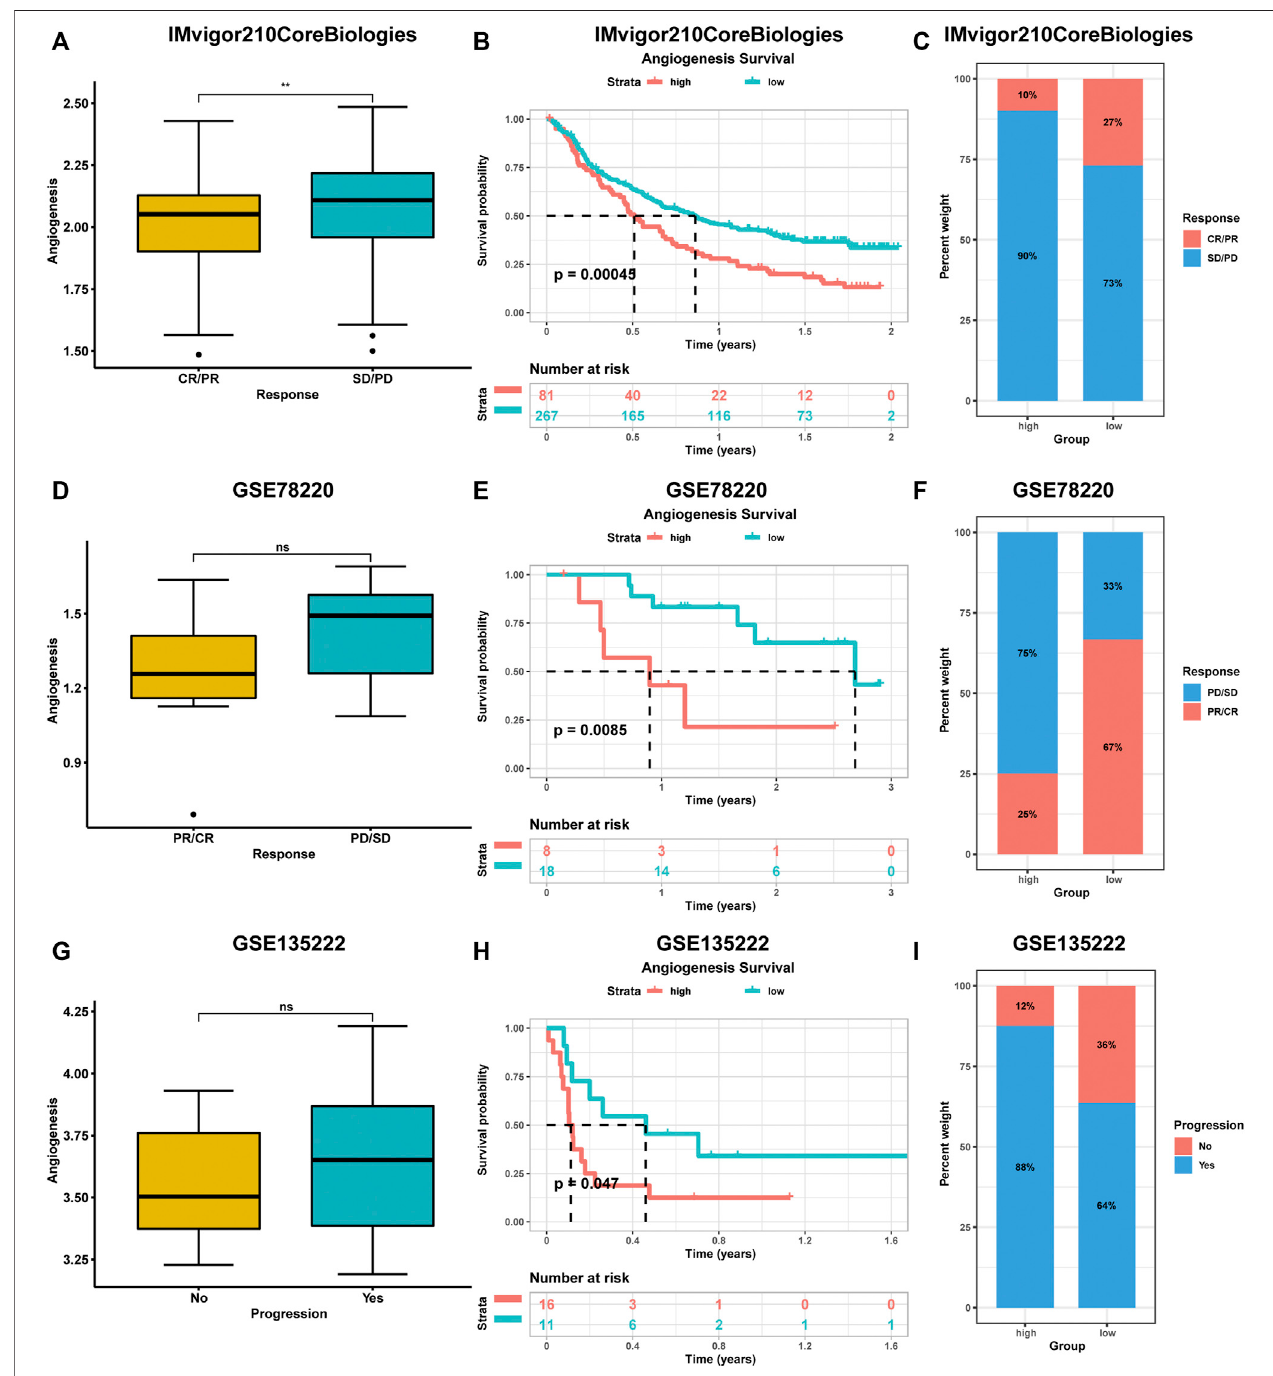
FIGURE 6 | The impact of angiogenesis scores on the prognostic outcome of immunotherapy patients was analysed using multiple datasets (A-I) . Patients with high angiogenesis scores exhibited poorer prognostic outcomes after immunotherapy. complete responses (CR), partial responses (PR), progressive disease (PD), stable disease